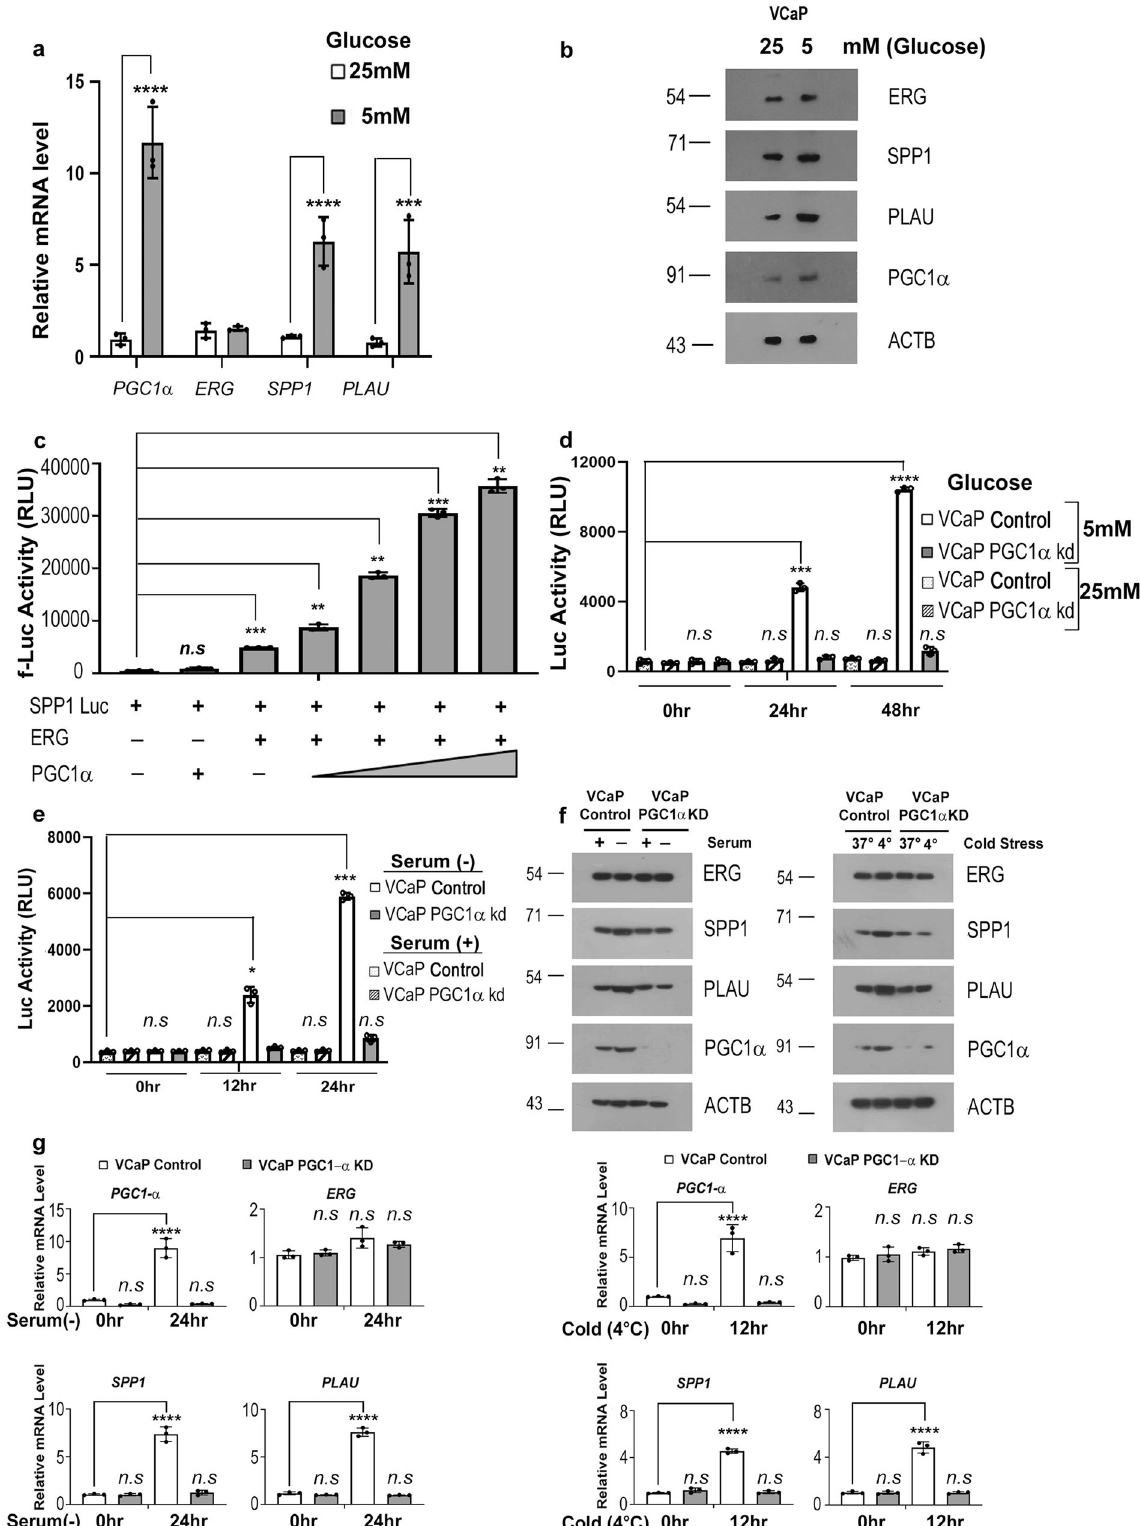
interacts with PGC1 α during metabolic stress (Fig. 2b). Interest- ingly, we observed that ERG interacts with a deacetylated form of PGC1 α but not with the acetylated PGC1 α , suggesting that an induced and activate form of PGC1 formed during metabolic stress is capable of interaction (Fig. 2a, b). We con fi rmed the interaction using overexpression studies in VCaP and PC3 cells and found